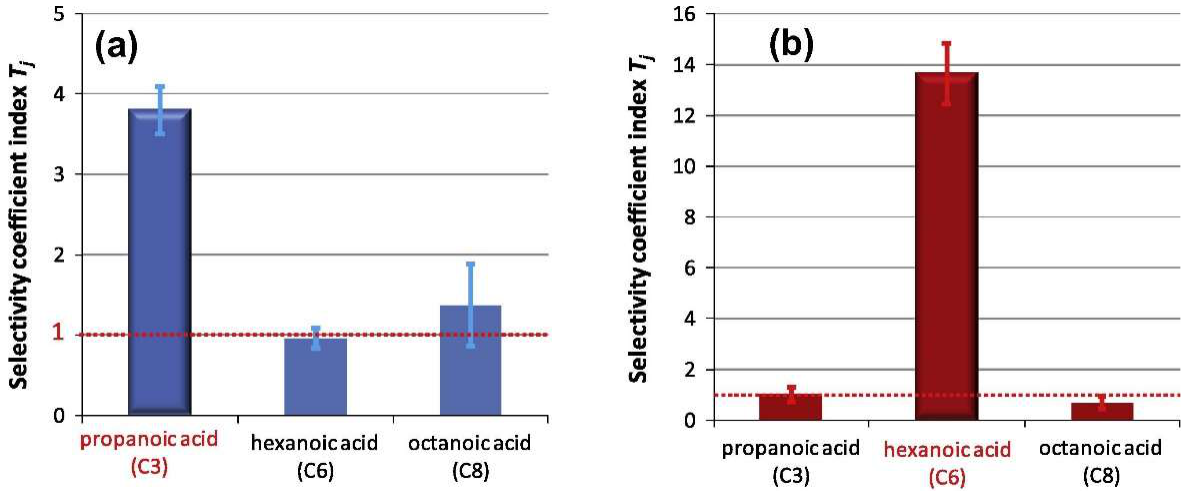
Figure 14. Binding of targets (red text) to their MIPs relative to non-imprinted polymers: ( a ) propa- noic acid imprinted polymer binding to propanoic acid, hexanoic acid and octanoic acid relative to non-imprinted polymer, ( b ) hexanoic acid imprinted polymer binding to propanoic acid, hexanoic acid and octanoic acid relative to non-imprinted polymer. Reproduced with permission [23].